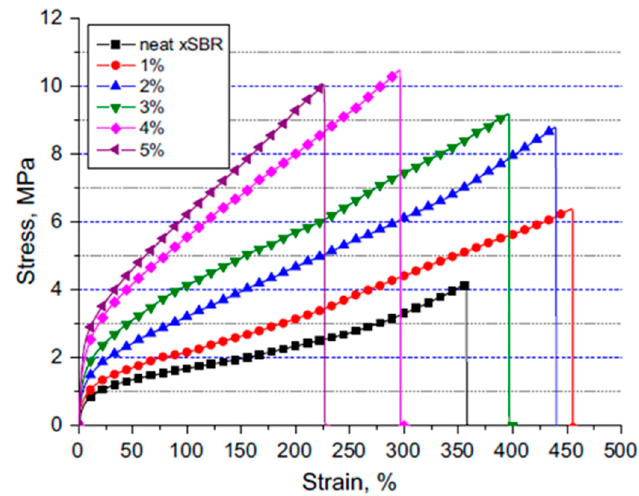
Figure 7. The tensile stress–strain curves for xSBR and xSBR/chitin nanocrystals nanocomposites [63].